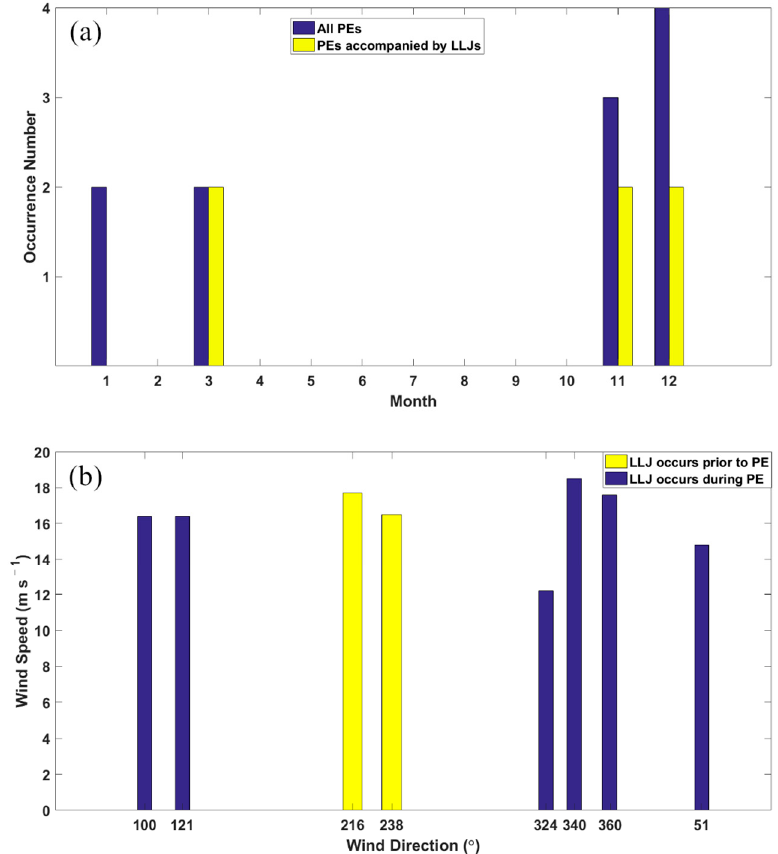
Figure 4. ( a ) Monthly occurrence numbers of all PEs and PEs accompanied by LLJs. ( b ) Wind speed and wind direction of LLJs, which occurred before the onset of PEs (yellow) and during PEs (blue) in Tianjin in